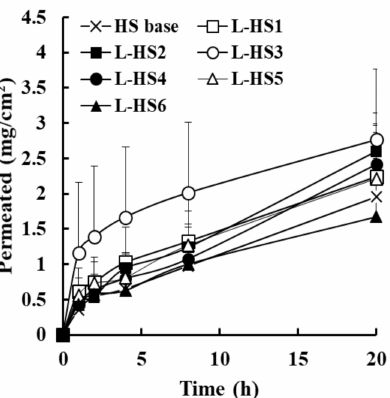
Figure 2. In vitro permeation profile of efinaconazole through the bovine hoof from L-hydroalcoholic solutions (HSs) with different lipophilic enhancers in the Franz diffusion cell model. Data represent mean ± standard deviation ( n =